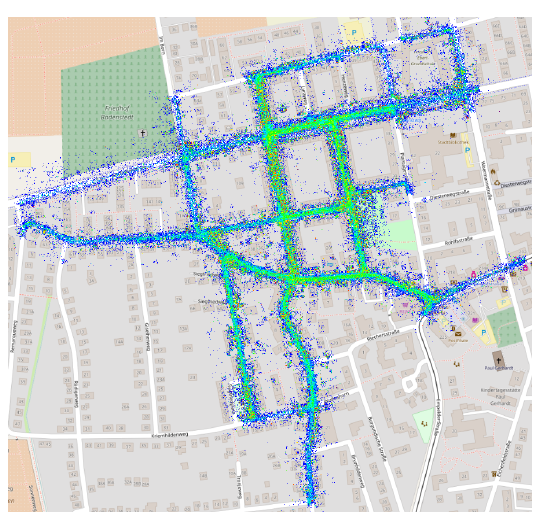
Figure 2. Measurement area in Hannover-Badenstedt (Germany). The scan points are colored by the maximum height difference in every grid cell, from blue (0 cm) to red (2